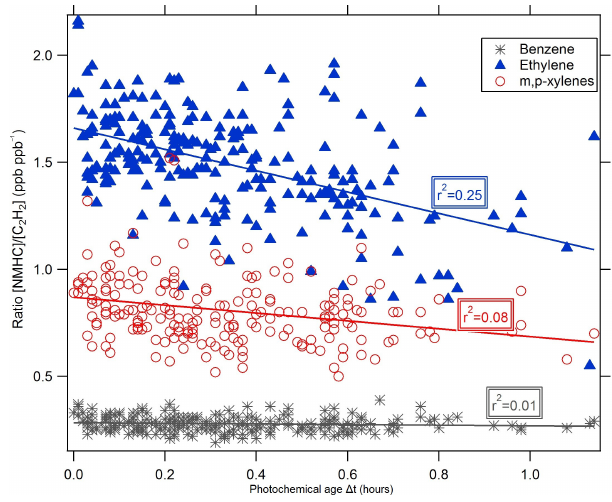
Figure 4. Measured ratios of benzene / acetylene, m,p- xylenes / acetylene, and ethylene / acetylene as a function of photochemical age